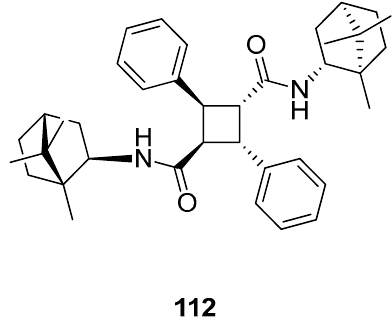
Figure 28. α -Truxillic acid derivative with (+)-camphor fragment.